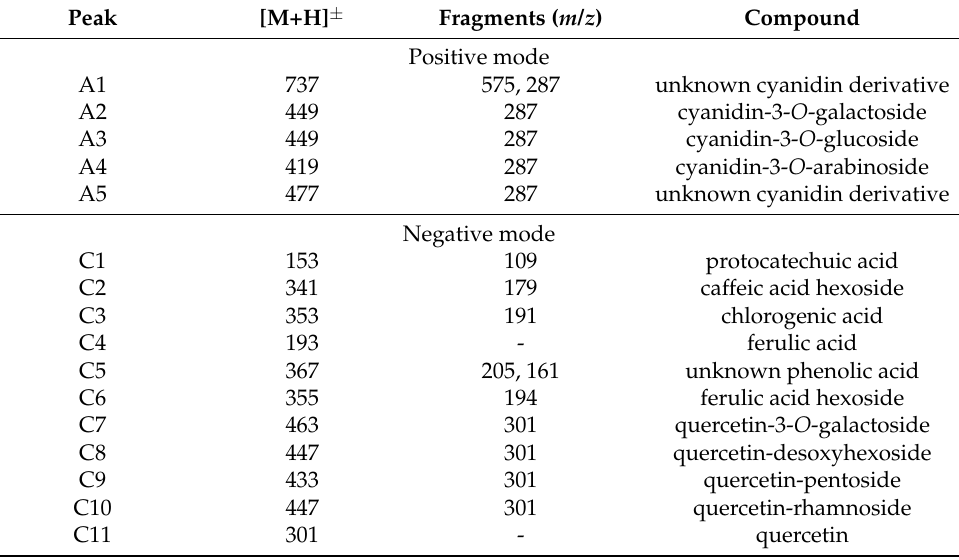
Table 1. Compound identification of the anthocyanin (A1–A5) and copigment fraction (C1–C11) of the lingonberry ( Vaccinium vitis-idaea L.) XAD-7 extract by HPLC-ESI-MS/MS. Peak [M+H] ±